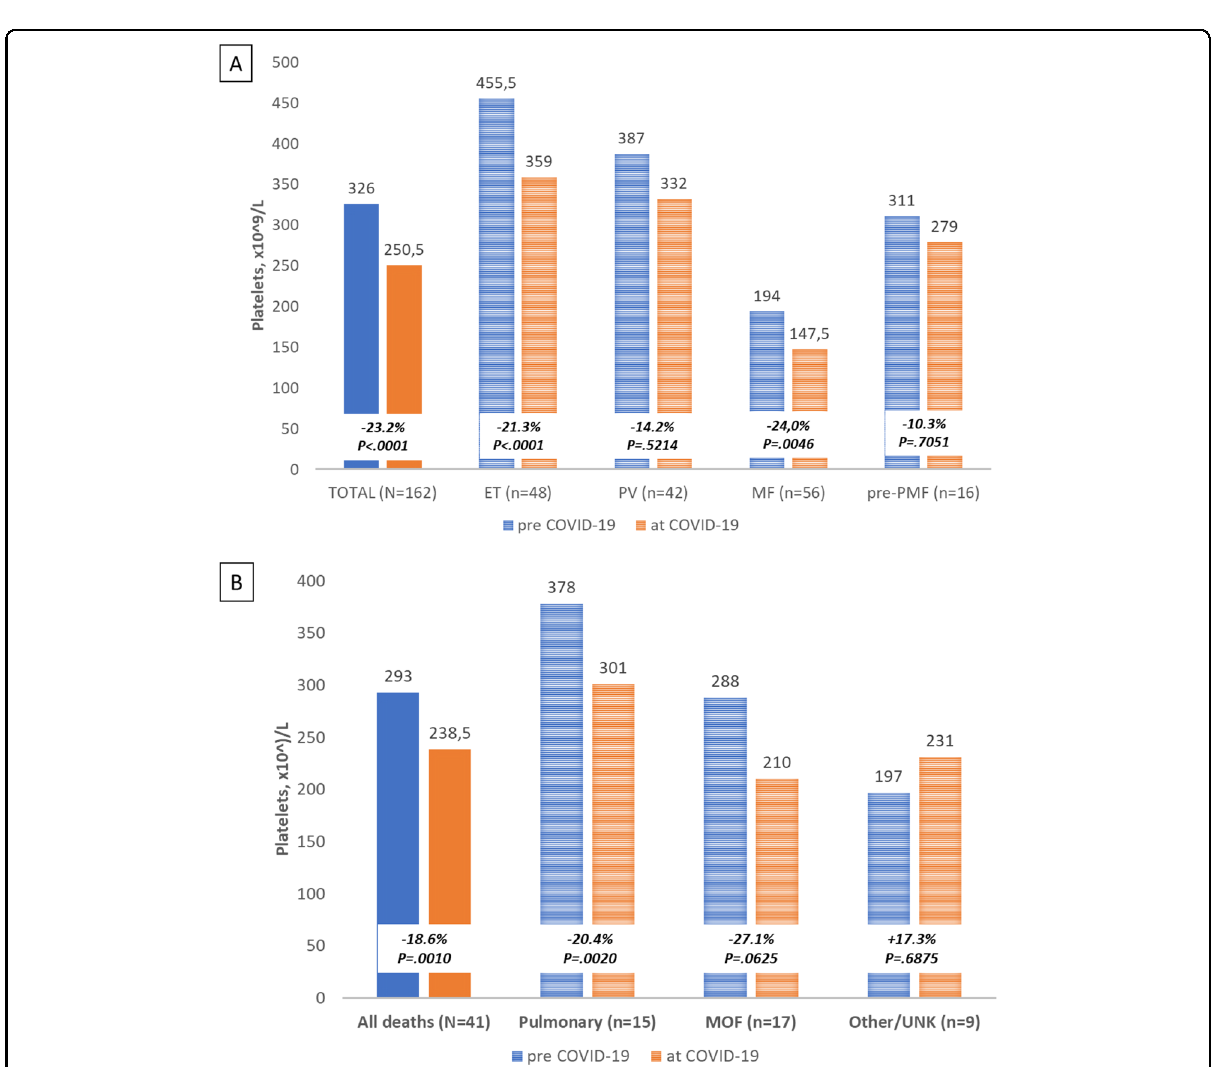
Fig. 2 Platelet changes at COVID-19. Median platelet counts before and at COVID-19 diagnosis, by MPN phenotype ( A ) and by causes of death ( B